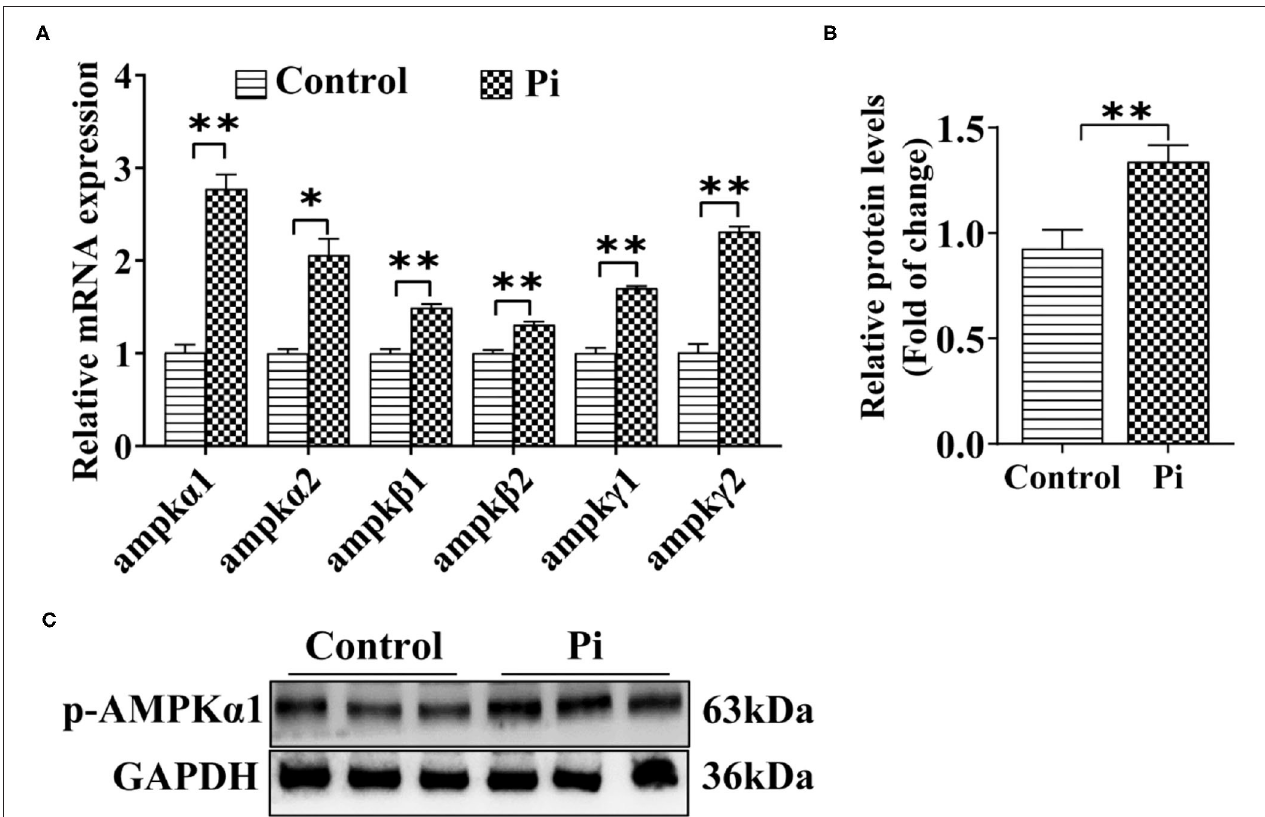
FIGURE 4 | Phosphorus incubation activated AMPK pathway in tilapia hepatocytes. (A) Relative mRNA abundances of genes related to AMPK pathway. (B,C) Western blot analysis and quantification analysis of p-AMPK α 1 protein levels. All data are expressed as mean ± S.E.M ( n = 3). P value was calculated by the Student’s t tests. * P ≤ 0.05, ** P ≤ 0.01, compared with the control.